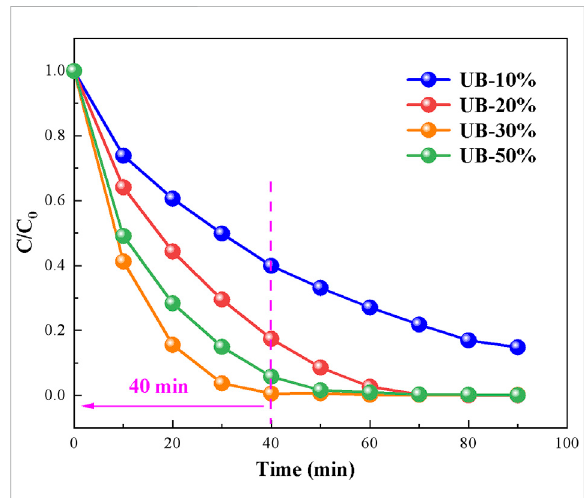
FIGURE 8 PhotocatalyticdegradationofRhBbyphotocatalystprepared under direct visible light